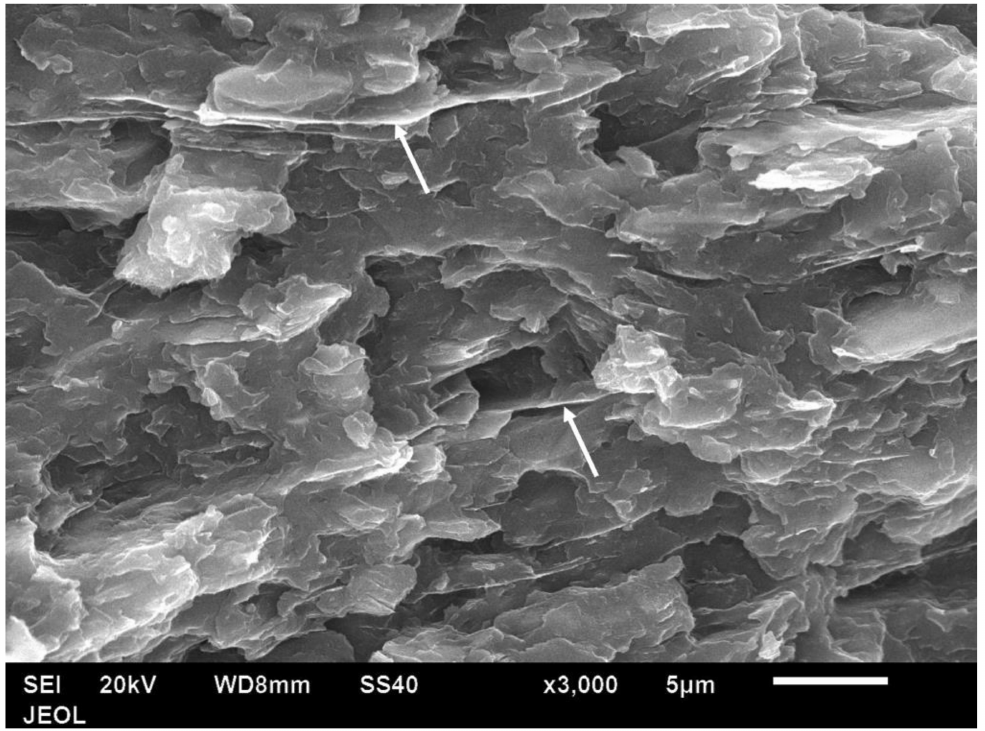
Figure 19. Fracture surface of 25 vol.% Al platelet–amorphous PET. Al flakes are seen only edgewise (arrow). Arrows show a protruding flake covered with